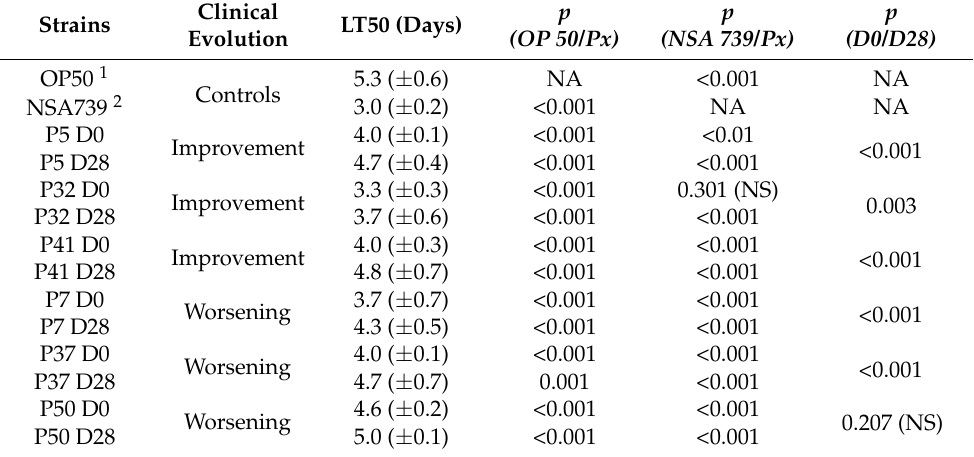
Table 4. 50% Lethal Time (in days) of Caenorhabditis elegans infected by 12 S. aureus strains isolated from six patients with PU at D0 and D28. The results are representative of at least three independent trials for each strains. Mantel Cox’s Test was used to compare OP50 or NSA739 with the 12 strains, and each strain between D0 and D28. Wilcoxon Mann Whitney Test was performed to compare LT50 of strains isolated from wounds with improvement versus strains isolated from worsening wounds. Clinical LT50 (Days) Strains Evolution